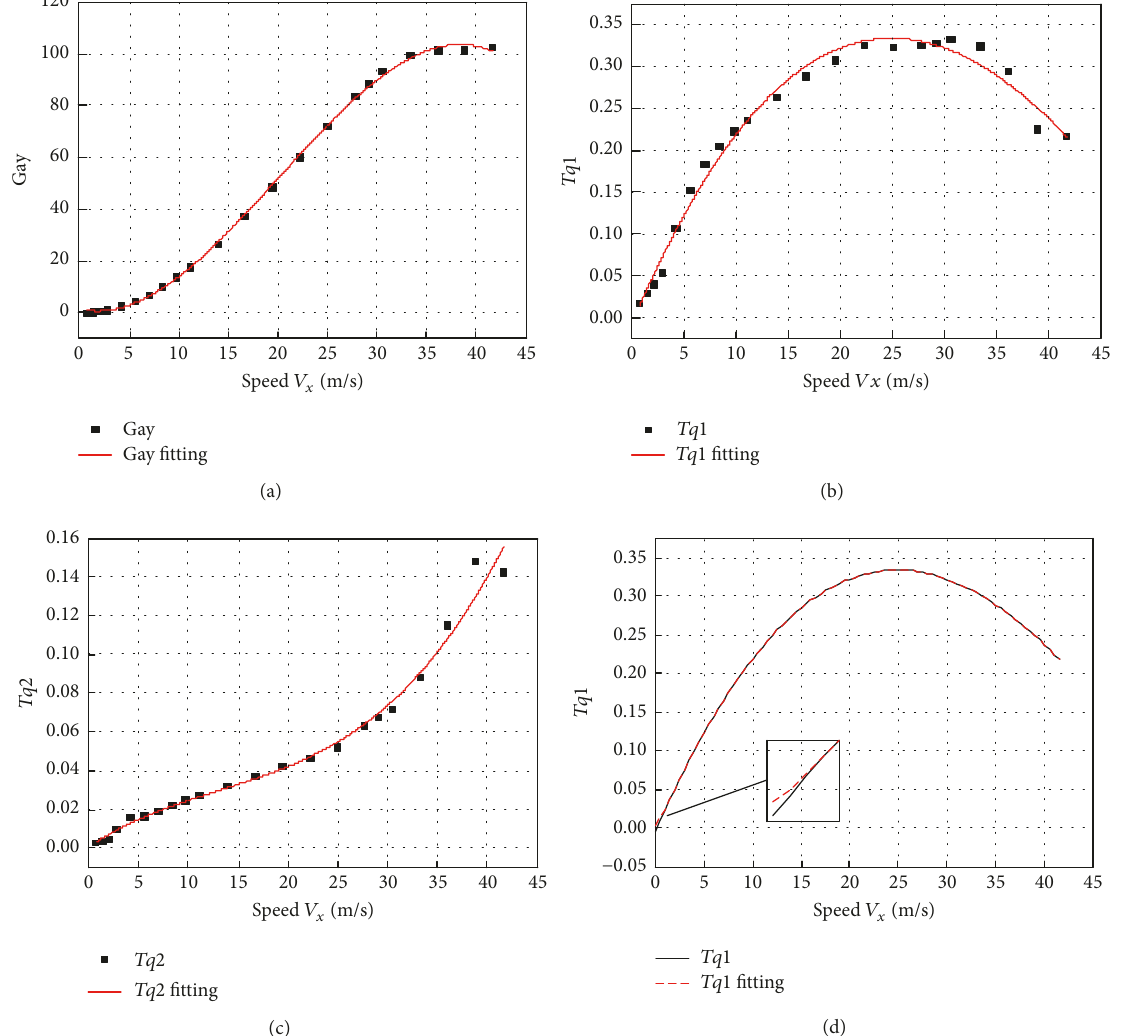
Figure 17: Fitting results. (a) 𝐺 𝑎𝑦 , (b) 𝑇 𝑞1 , (c) 𝑇 𝑞2 , (d) 𝑇 𝑞1